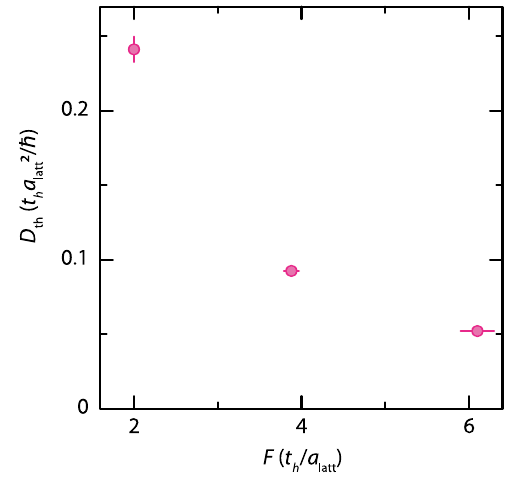
FIG. 4. Thermal diffusivity. Extracted thermal diffusivity (circles) vs gradient. The values are extracted by performing a fit of our hydrodynamic model to all wavelengths of each gradient simultaneously